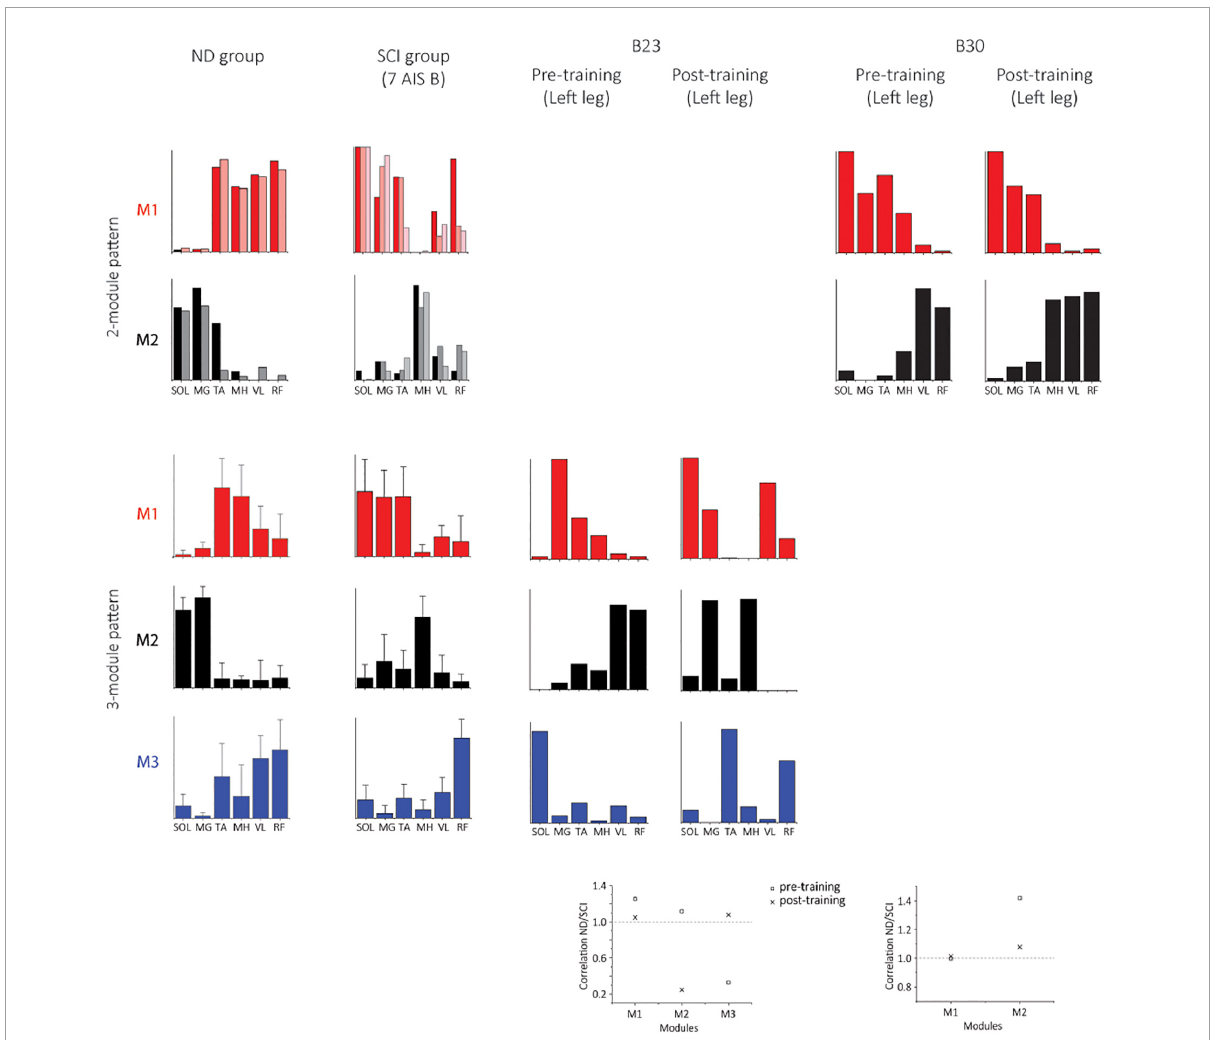
FIGURE7 Spatial synergy patterns from SF-NMF using 6 muscles in NDs, SCIs, and two successfully rehabilitated individuals (B23 and B30). Each panel shows spatial patterns from SF-NMF grouped by the number of modules that explain ≥ 90% variance. In the 2-module patterns of the ND and SCI groups, each bar represents a spatial synergy pattern from a leg. The 3-module patterns of ND and SCI groups represent group mean + SD. The scatterplots on the bottom represent the ratio of the maximum absolute correlation of each module between the ND and SCI group mean synergies (2- or 3-modules) in B23 (3 modules) or B30 (2 modules). The ratio of greater than 1 indicates that the module exhibits greater similarity to the NDs than to the